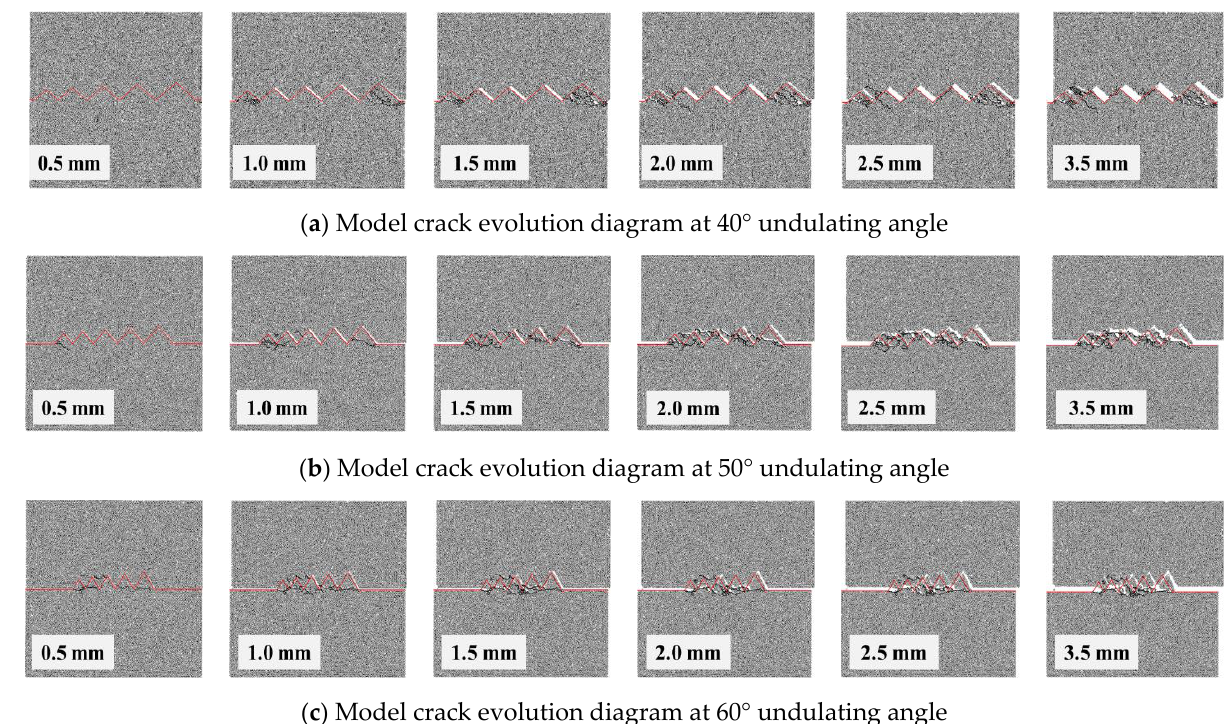
Figure 14. Model crack evolution under different undulating